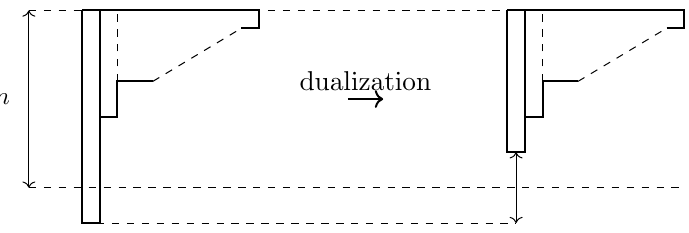
Figure 2 . Example of a Young diagram with a (cid:12)rst column higher than n (left) and the Young diagram obtained after dualization